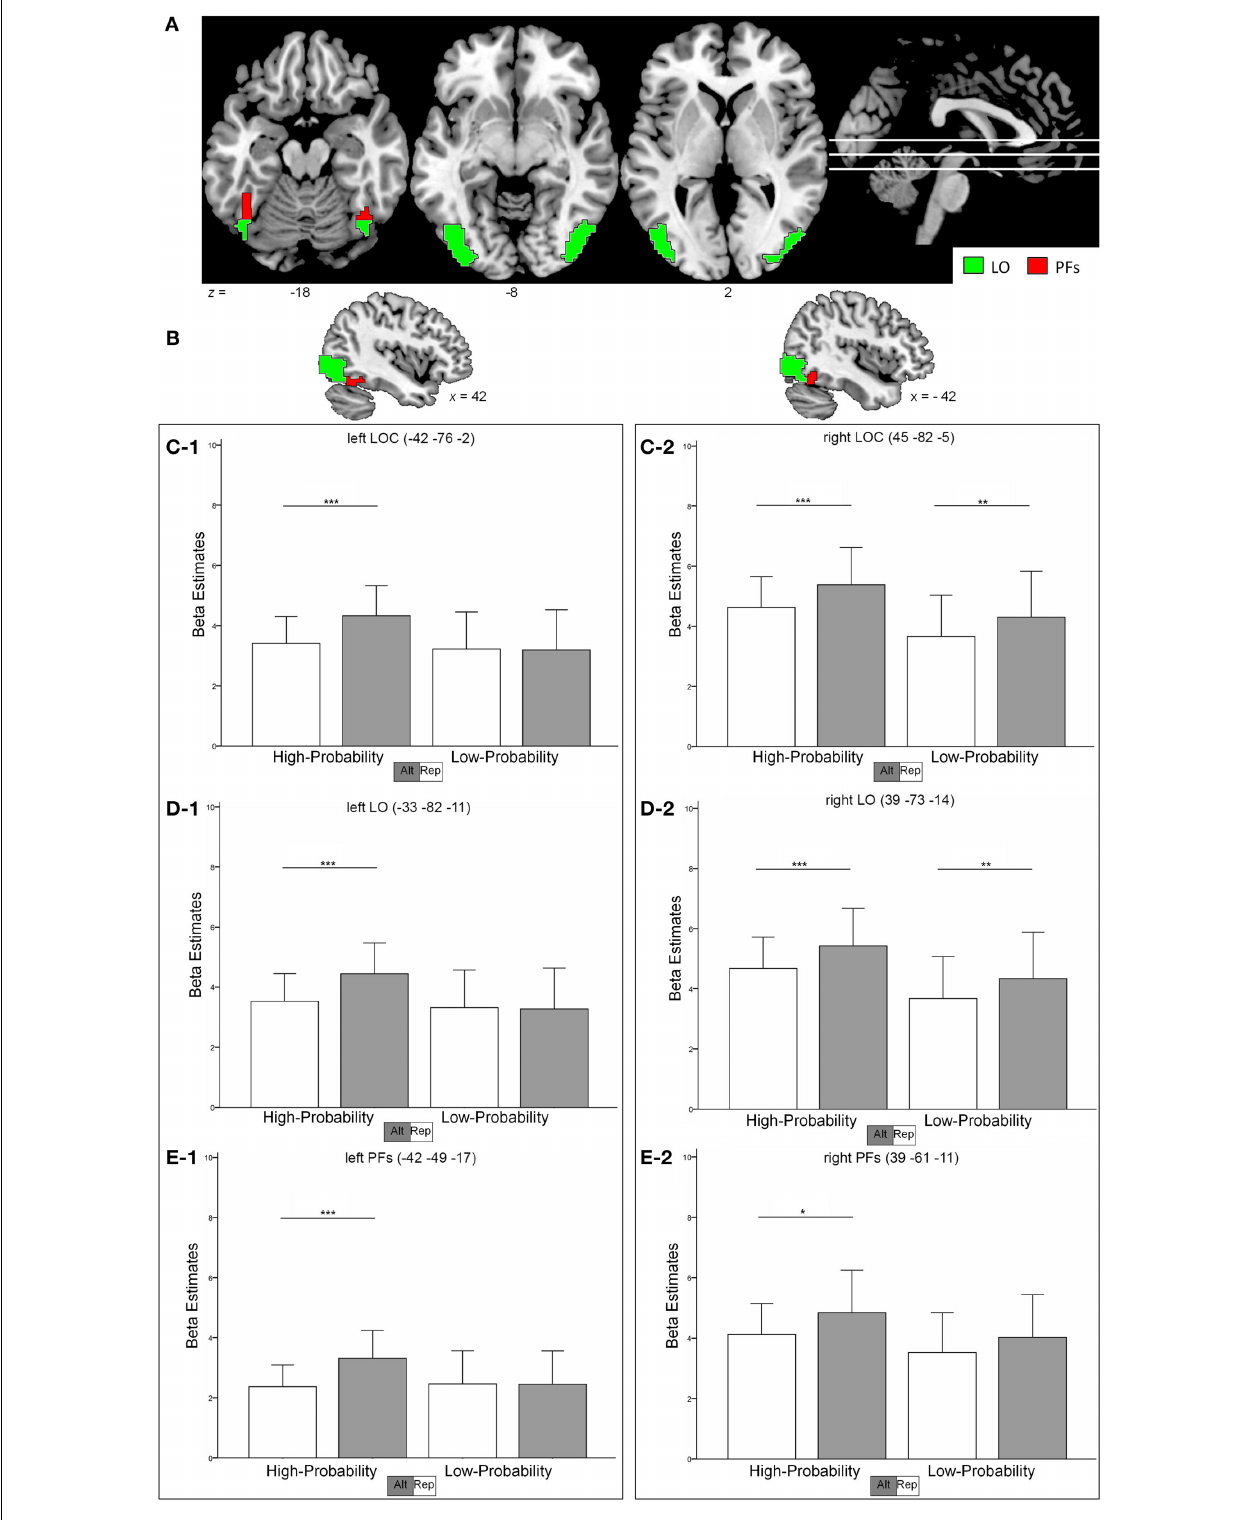
FIGURE 2 | (A,B) shows the location of the LOC (sum of red and green clusters) as identified in the functional localizer. The subregions LO and PFs are depicted as green and red regions, respectively. (C–E) , Contrast